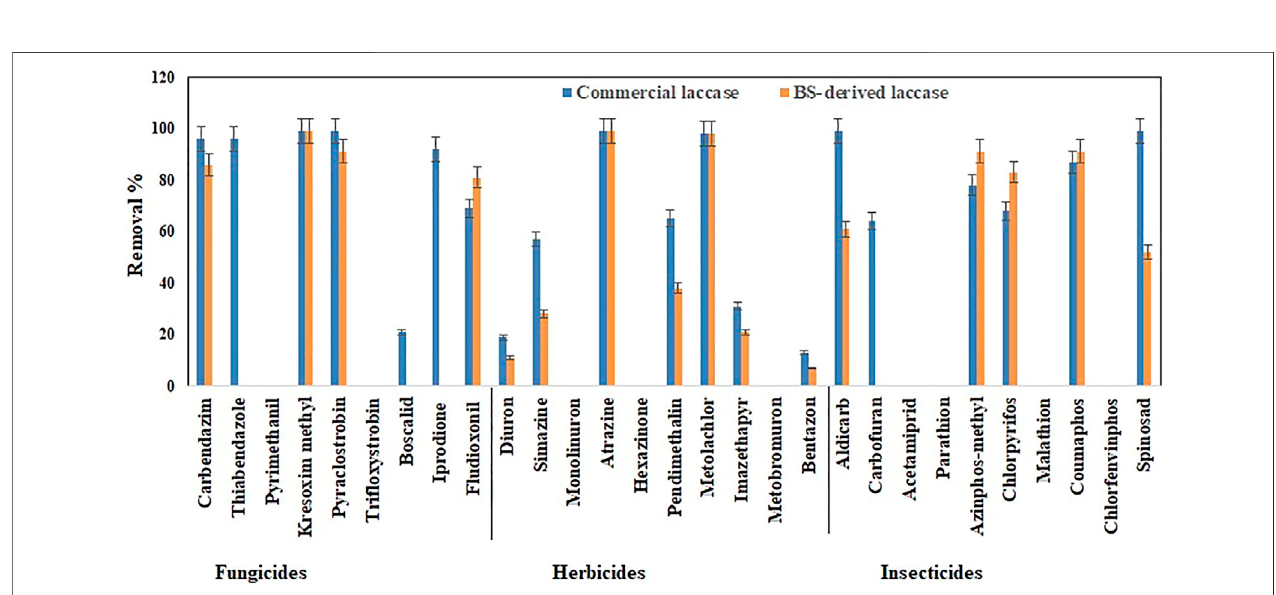
FIGURE4| Bio-catalyticremovalof29pesticidecompoundstreatedseparatelyinaqueoussolutionby Pleurotusdryinus laccasederivedfromBSandcommercial laccase during 24 h. The experiments were done in triplicate at pH 7.0 and 20 ° C, and the error bar represents the percentage error at 5% level of signi fi cance.